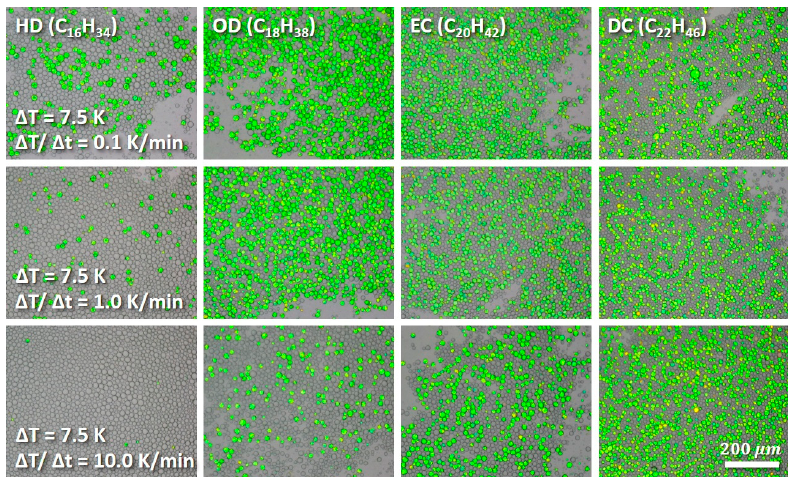
Figure A3. Micrographs of 1 wt % alkane dispersions at Δ T = 7.5 K during supercooling with different cooling rates. Length of the scale bar is 200 µm.